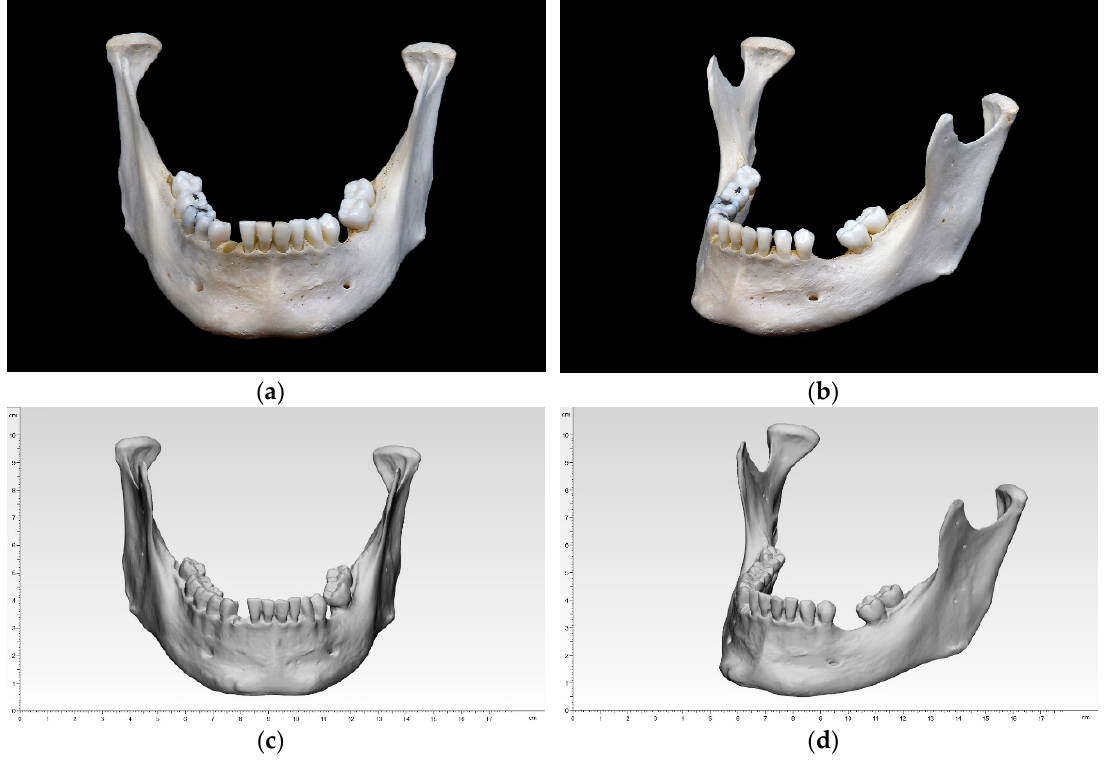
Figure 1. Bony mandibular reference: ( a ) front view; ( b ) side view; digitized mandibular (standard tessellation file (STL)) in 3-matic medical: ( c ) front view; ( d ) side view.